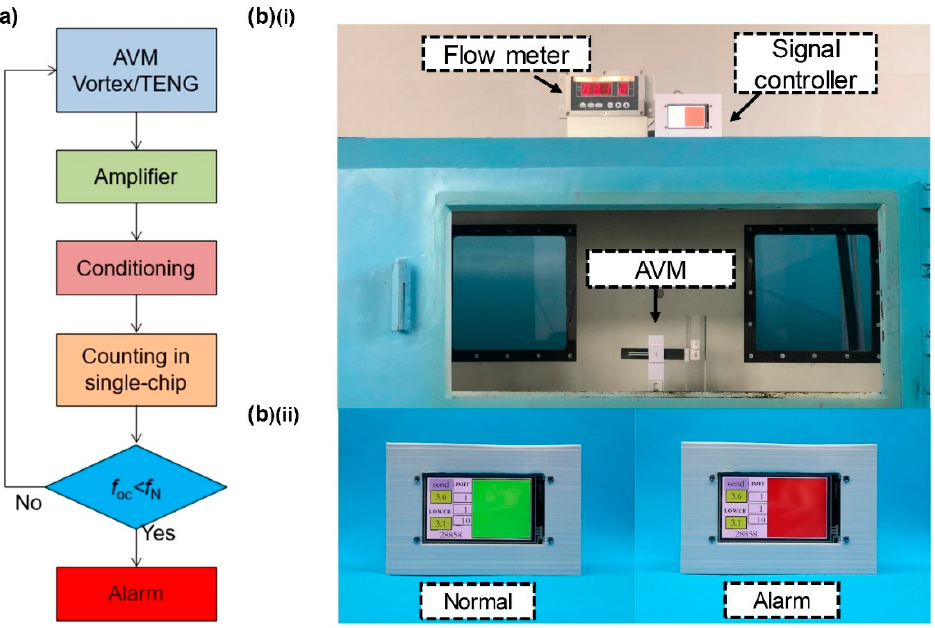
Figure 6. Demonstration of AVM application: ( a ) signal processing of the AVM; ( b ) test setup and the controller: (i) arrangement of test equipment and (ii) the situation when the controller displays normal or alarm.